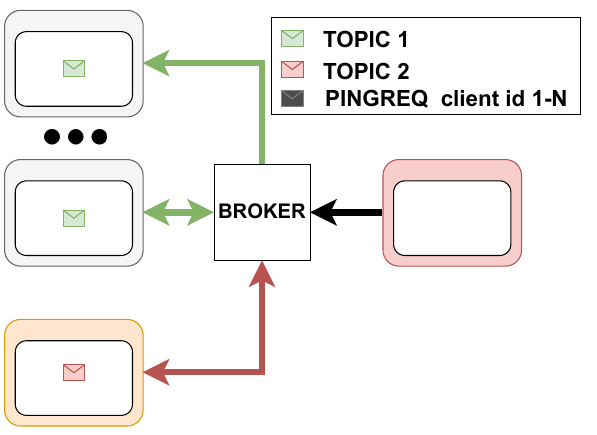
Figure 24. MQTT-SN wake up wave attack